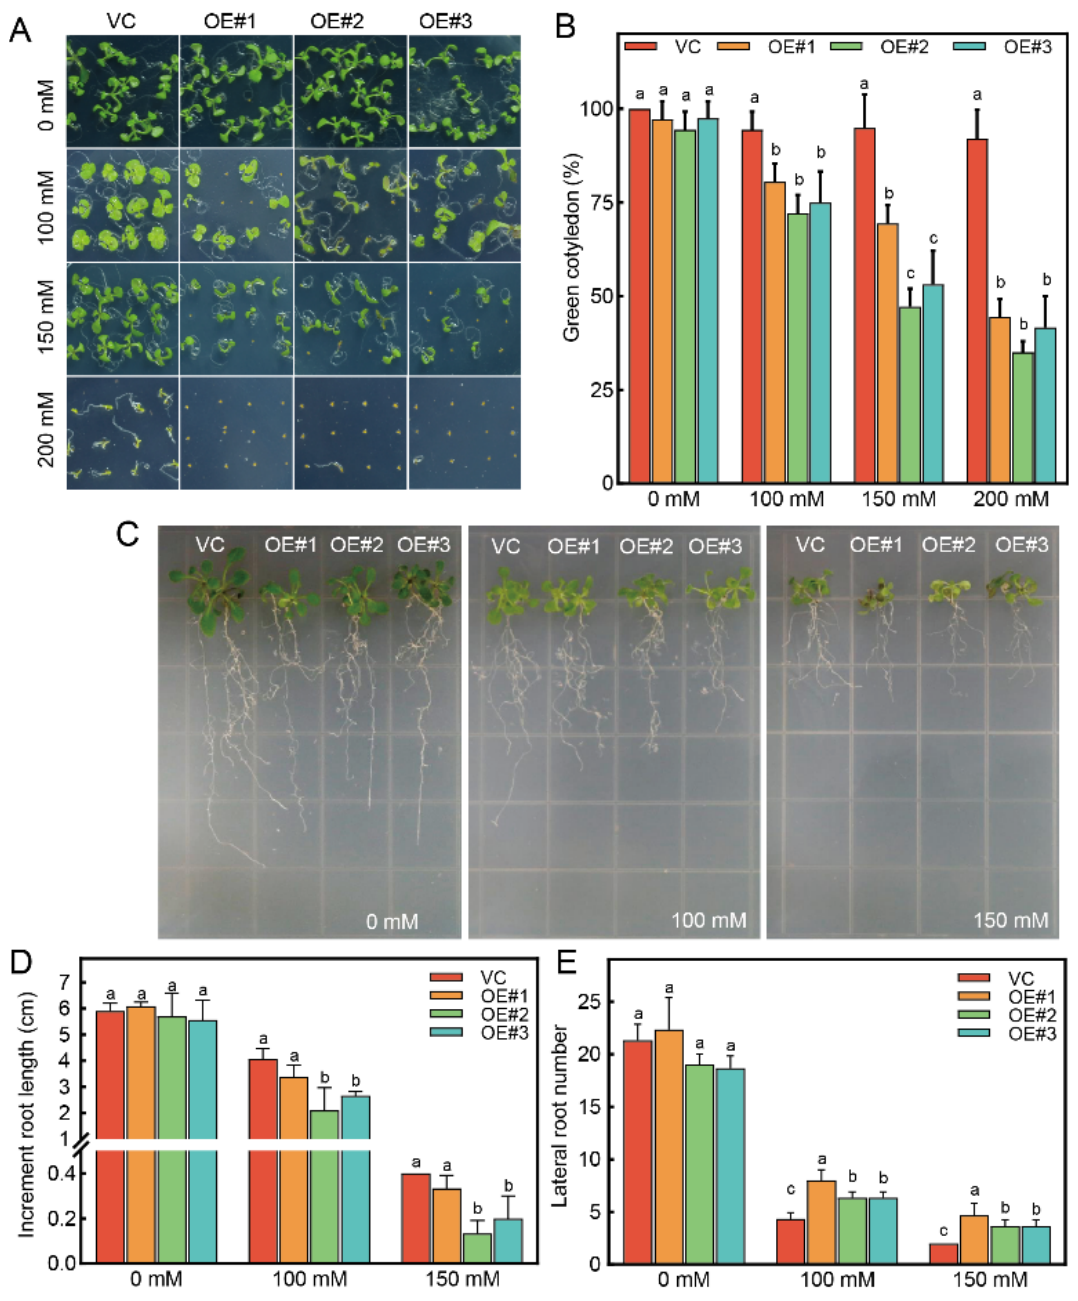
Figure 4. Salt stress response of RcTINY2 -OE Arabidopsis plants. ( A ) Differential seed germination responses between RcTINY2 -OE and VC plants on NaCl-treated (0, 100, 150 and 200 mM) MS agar plates; ( B ) Green cotyledon rates of VC and RcTINY2 -OE seeds seven days after NaCl treatment; ( C ) Phenotypic difference in root growth between RcTINY2 -OE and VC plants in response to NaCl; ( D ) Root growth increment and ( E ) Number of lateral roots in RcTINY2 -OEs and VC plants under salinity stress. Ten-day-old VC and RcTINY2 -OE seedlings were transferred to NaCl-treated (0, 100 or 150 mM) MS media and grown for ten days. All data are the mean ± standard deviation (SD) for three biological replicates. LSD tests were used to determine statistically significant differences ( p < 0.05) which are indicated by different